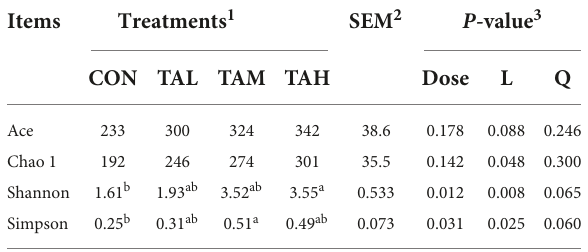
TABLE 6 Effects of tannic acid at different supplemental levels on Alpha diversity indices of the bacterial community in the rumen fluid of Holstein